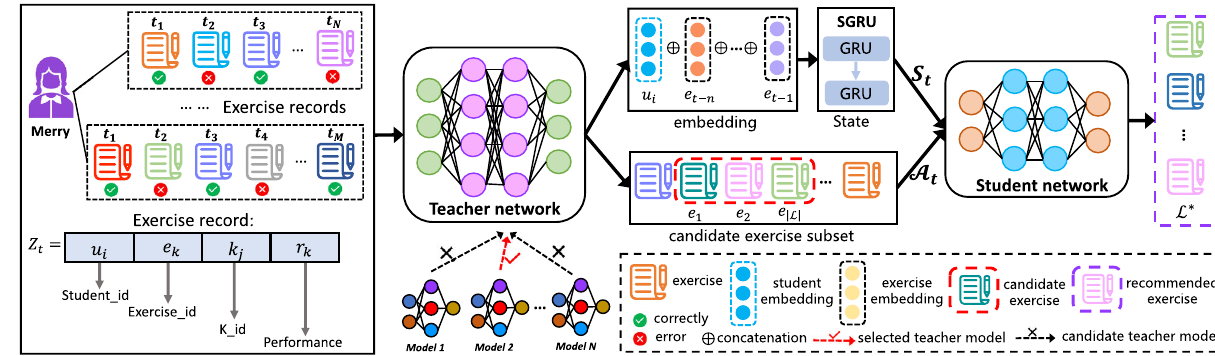
Fig. 3 TERD model architecture diagram